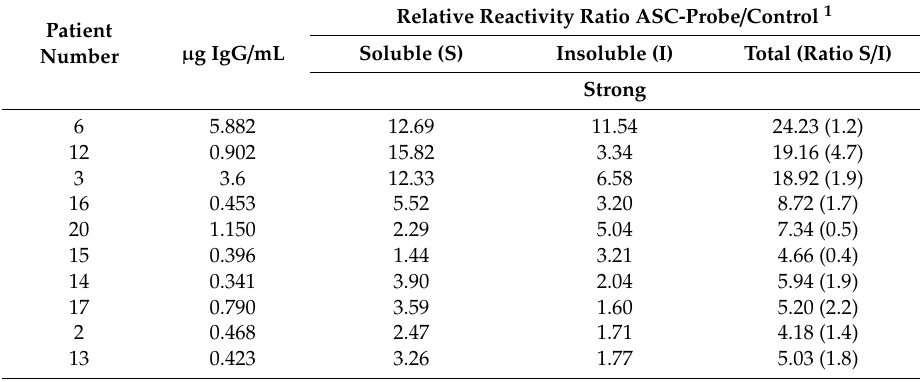
Table 2. IgG concentration and relative strength of reactivity of ASC-probes of 20 breast cancer